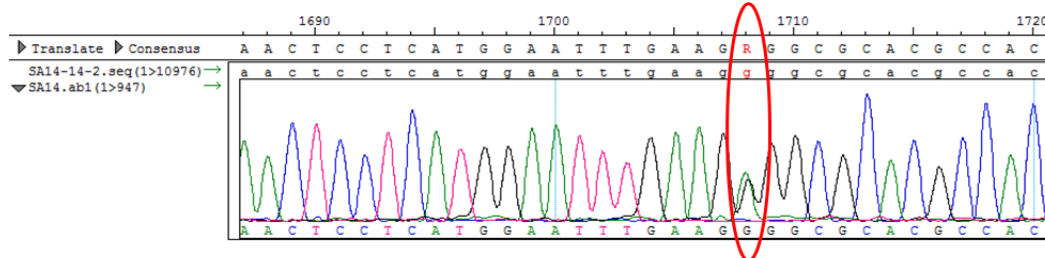
Figure 3. An equal proportion of two different amino acids exists at position E244 in the SA14 virus.